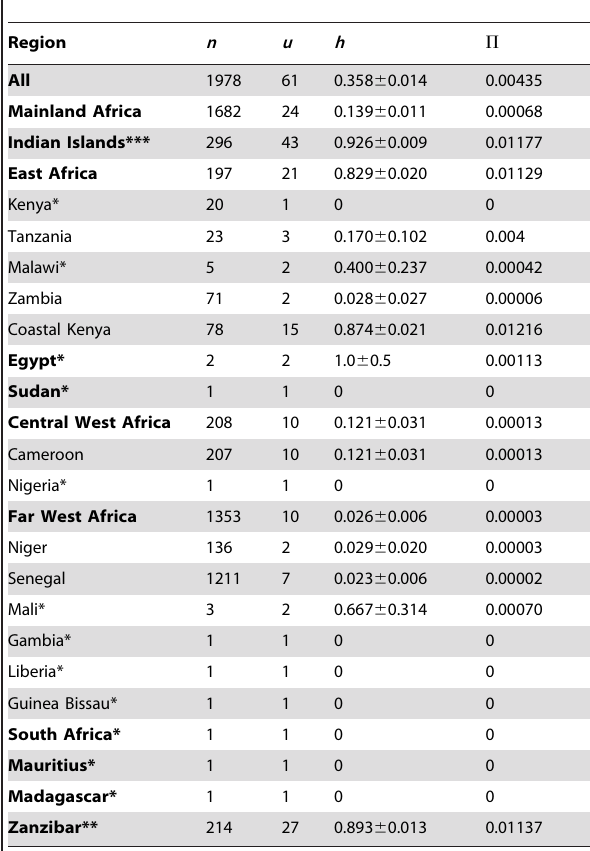
Table 1. Overall and regional cox 1